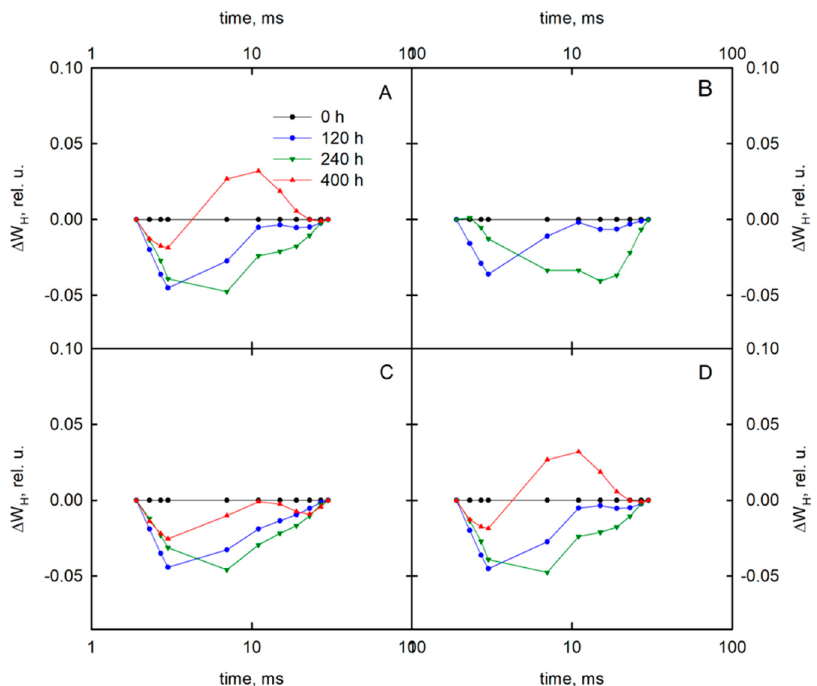
Figure A3. Di ff erential curves of ∆ W H (obtained by subtracting the control curve from the first sample time from 1.9 to 30 ms) of perennial ryegrass varieties (Roadrunner and Nira) under di ff erent field water capacity of soil (50 and 30% FWC) and time (0, 120, 240 and 400 h after stress application): ( A ) Roadrunner under 50% FWC, ( B ) Roadrunner under 30% FWC, ( C ) Nira under 50% FWC, ( D ) Nira under 30% FWC. n = 6. Relative units.